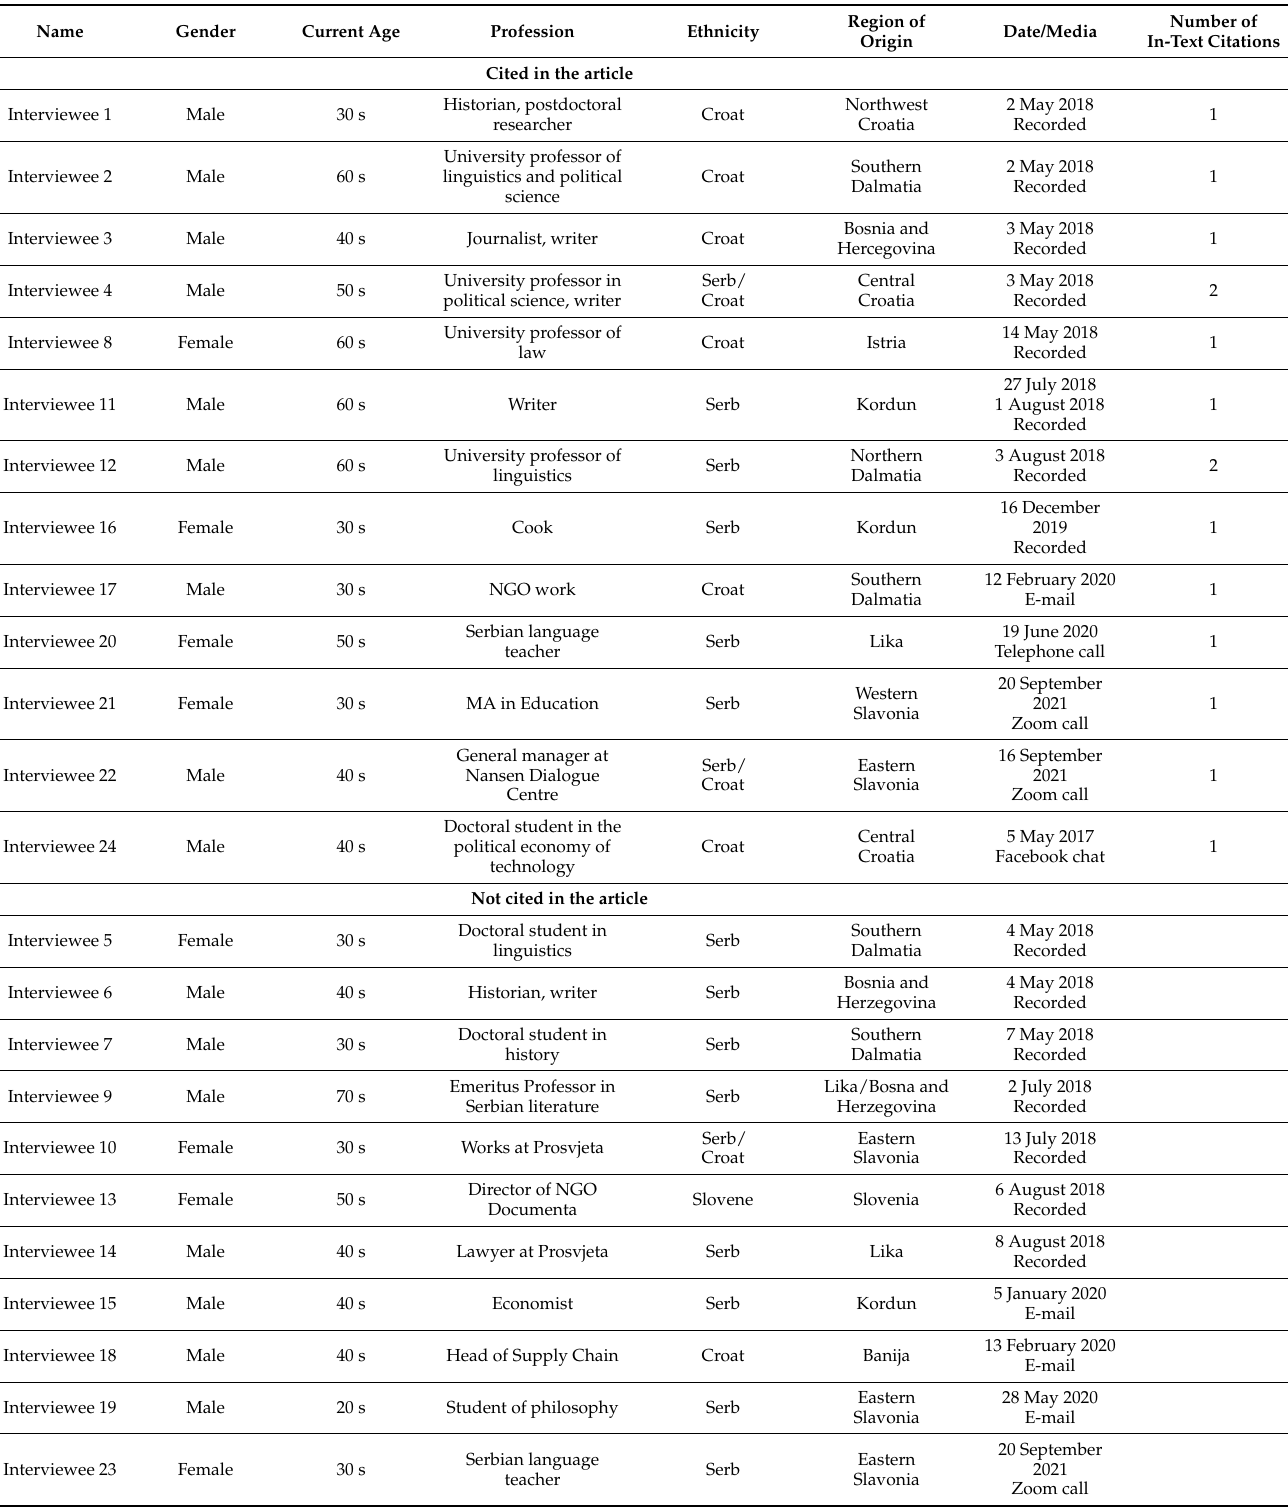
Table A1. The demographic characteristics of the